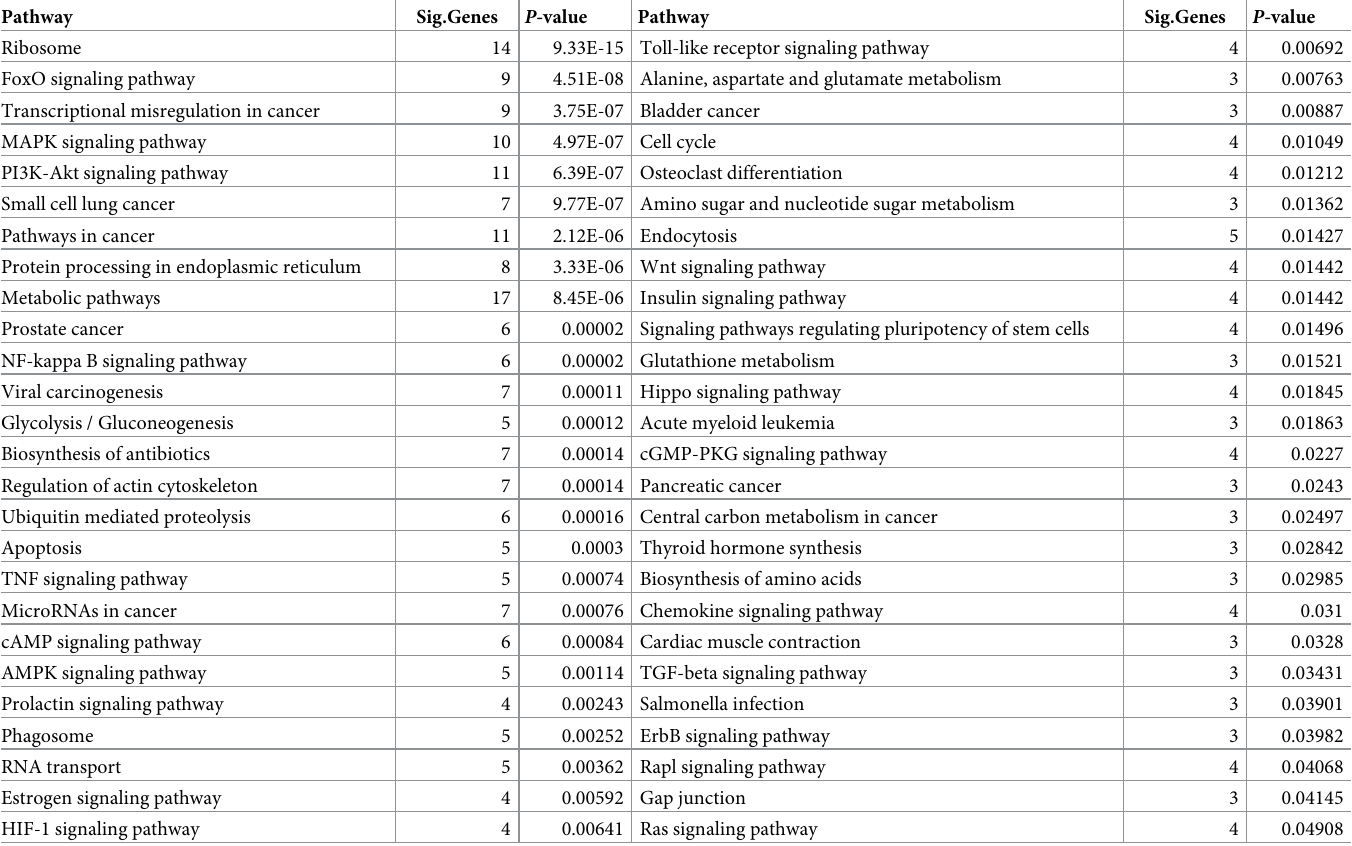
Table 1. Pathways significantly influenced by HPV16 E1 from gene expression